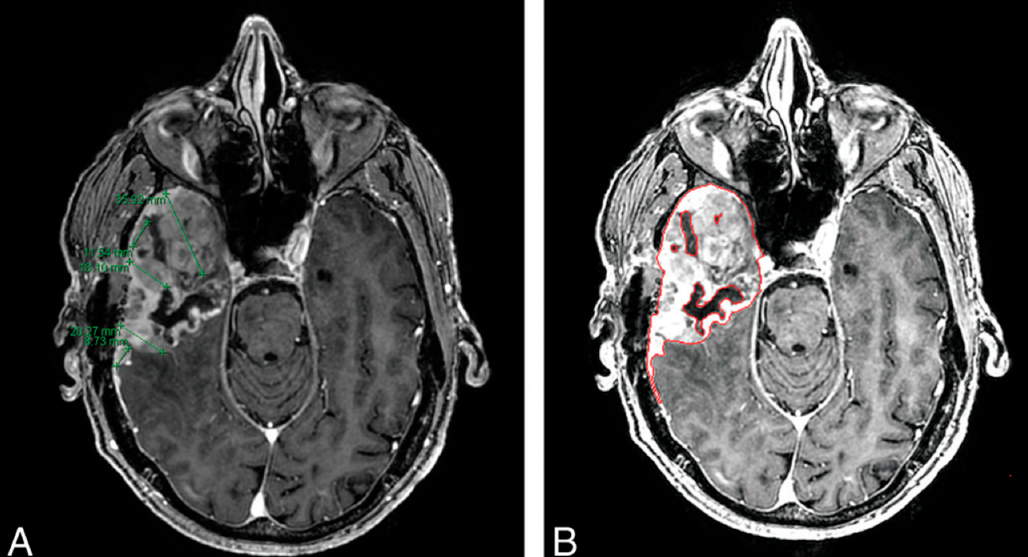
Figure 2. Comparison of linear 1D measurements ( A ) and machine learning volumetric analysis ( B ) in a 64-year-old man with GBM, 11 weeks following resection. Chow et al. [35] found volumetric analysis preferable given the irregularity of recurrence. Panel A indicates the challenges of selecting greatest dimensions in 2D, while panel B shows how a semi-automated volumetric approach can accurately capture greatest dimensions.